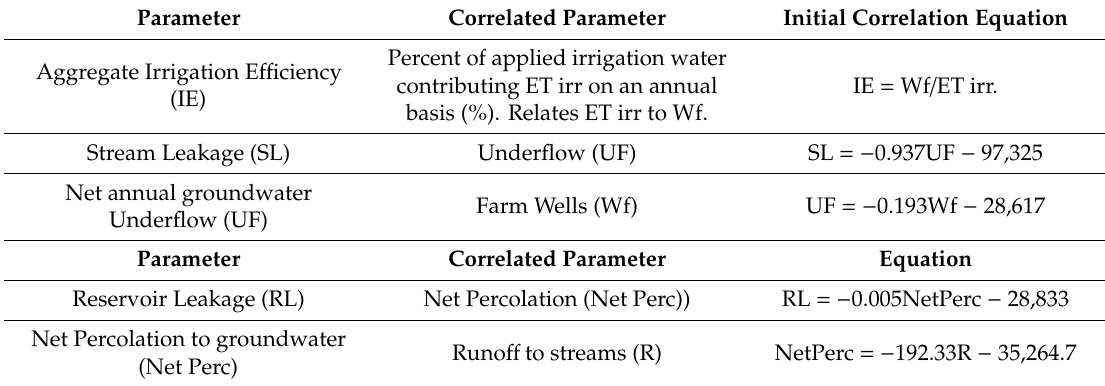
Table 5. Modesto simulated parameters and correlation equations